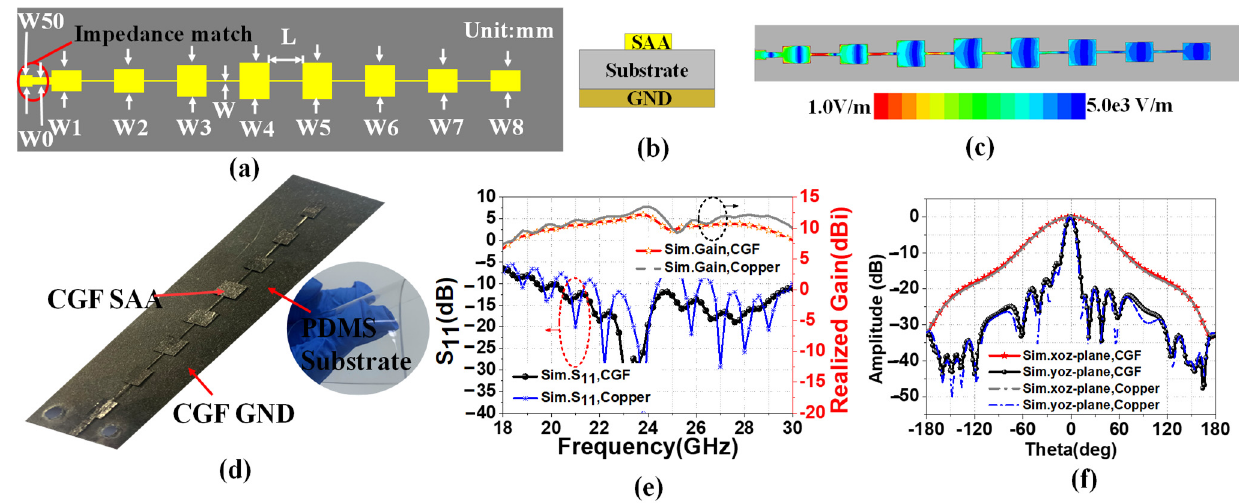
Figure 3. ( a ) Structure; ( b ) cross-section; ( c ) electric field distributions at 24 GHz; ( d ) physical picture of the proposed CGF antenna. Comparison of CGF and copper antennas in ( e ) reflection coefficients and peak gains; ( f ) xoz/yoz-plane radiation patterns.